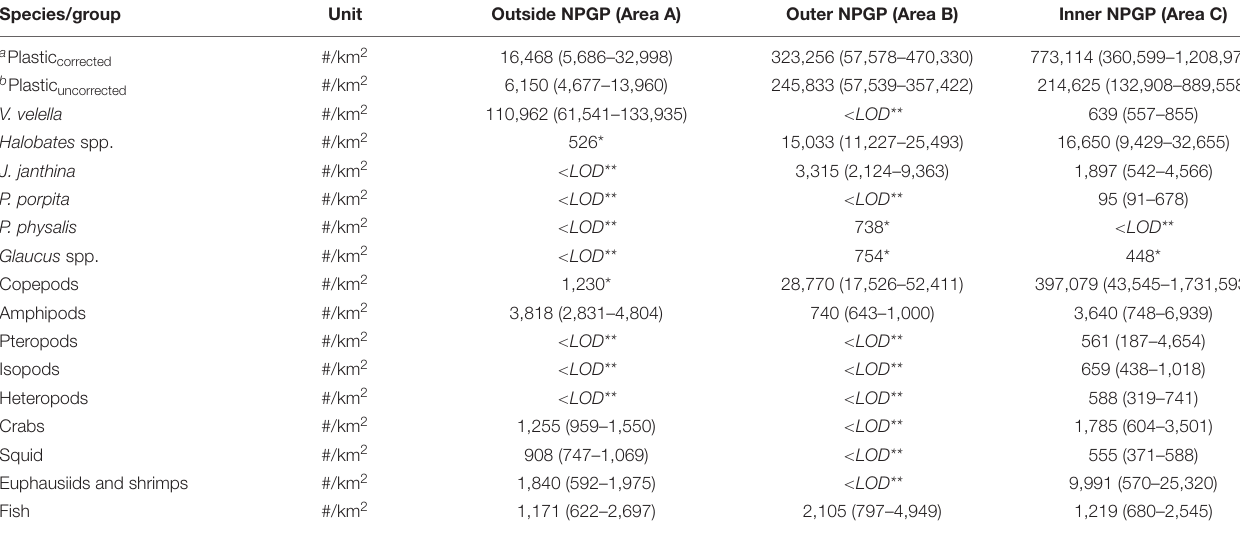
TABLE 1 | Numerical concentrations (#/km 2 ) of floating plastic debris (0.05–5 cm in size) and of different members of the neuston observed in the eastern North Pacific Ocean.